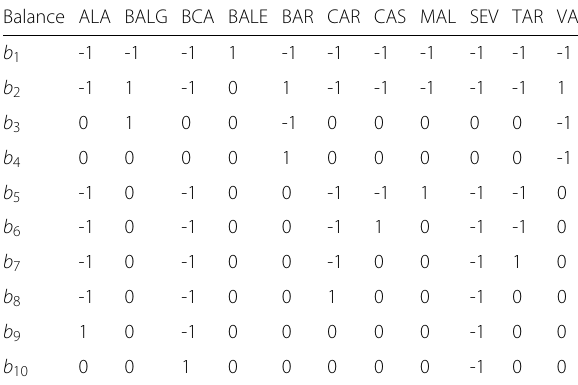
Table 5 Sequential Binary Partition for the SpanishMed port system